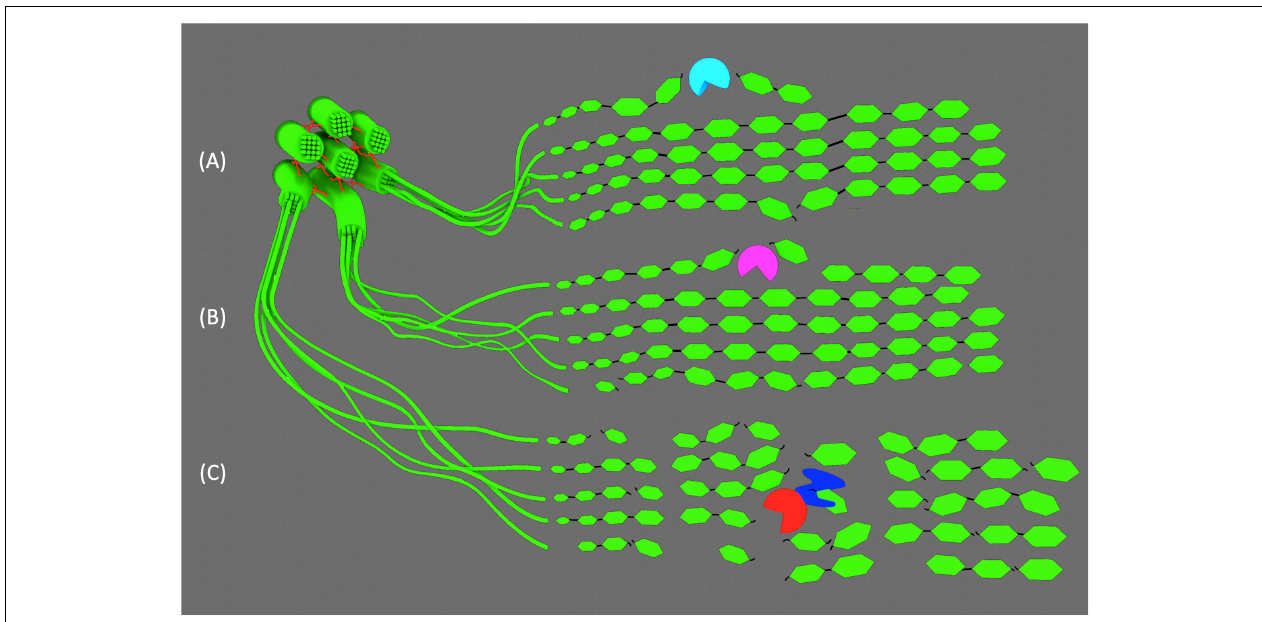
FIGURE 2 | GH cuts to cellulose microfibrils. (A) GH9B1 and GH9B3 and (B) thermophilic, CBM-truncated AcCel5A make relatively few cuts to superficial strands in the microfibril. (C) Mesophilic TrCel5A binds to cellulose via its CBM (blue), while the endoglucanase domain (red) makes cuts with significantly higher frequency due to its temperature optimum being similar to plant growth